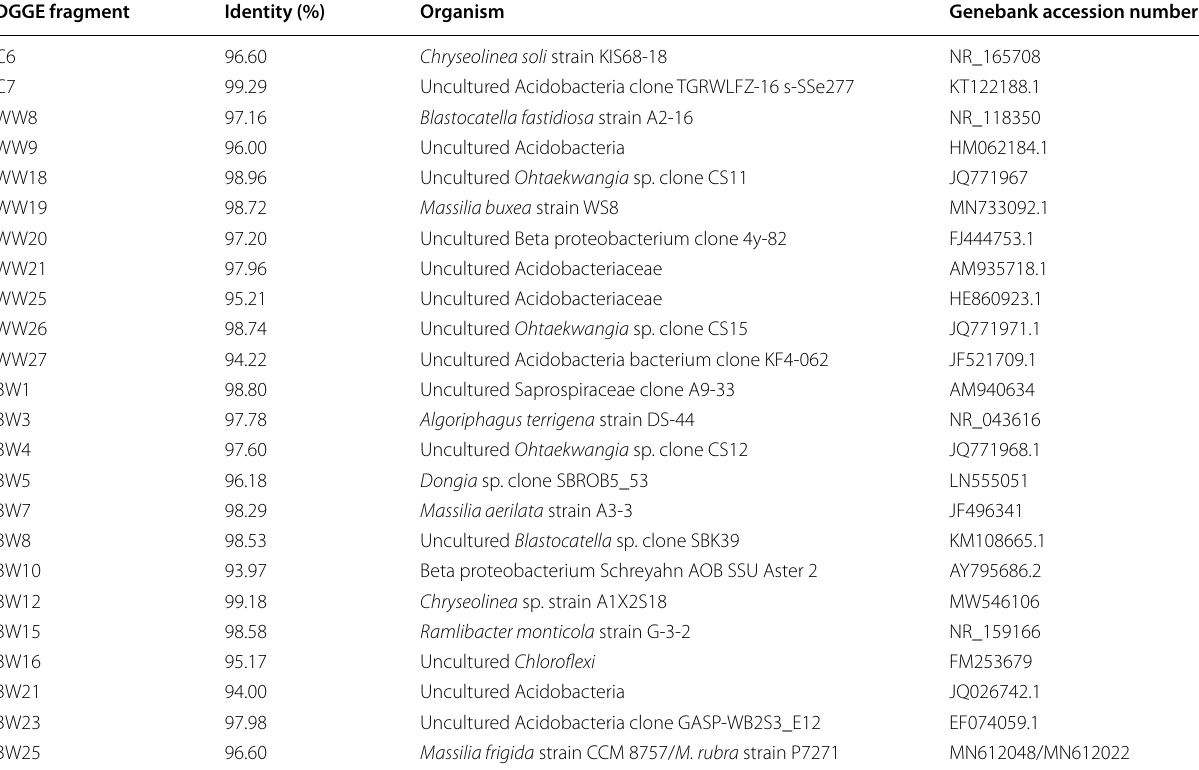
C untreated soil, WW white wool, BW black wool